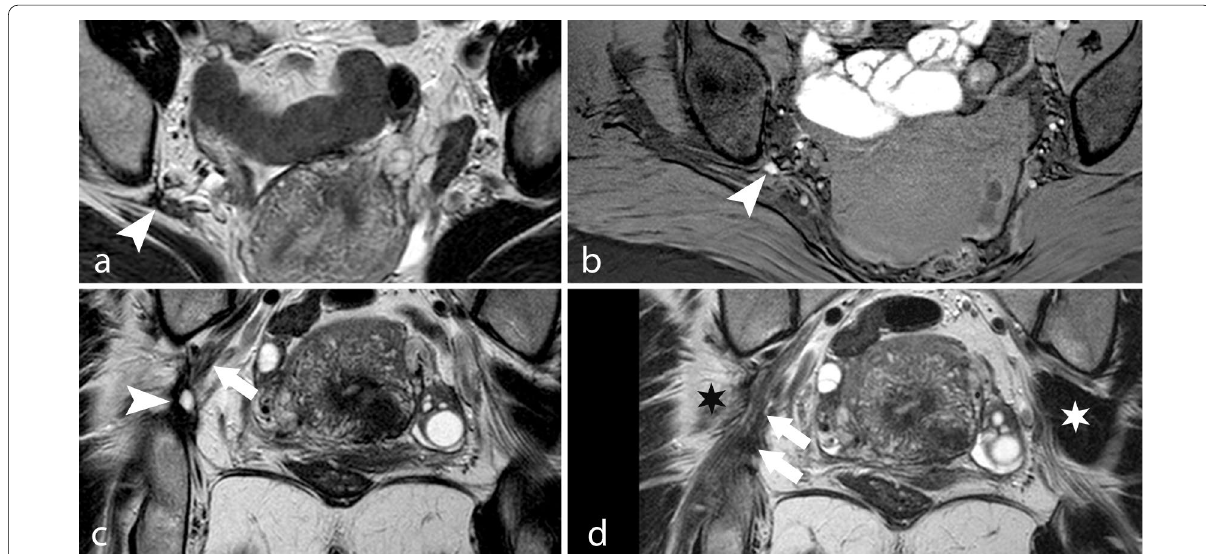
Fig. 15 Neural endometriosis. TSE T2w axial image ( a ), THRIVE axial image ( b ) and TSE T2w coronal images ( c , d ). A DIE nodule of the ischiatic foramen (arrowhead) surrounds the ischiatic nerve (arrows). Note the atrophy of the right piriformis muscle (black star) and normal left piriformis muscle (white